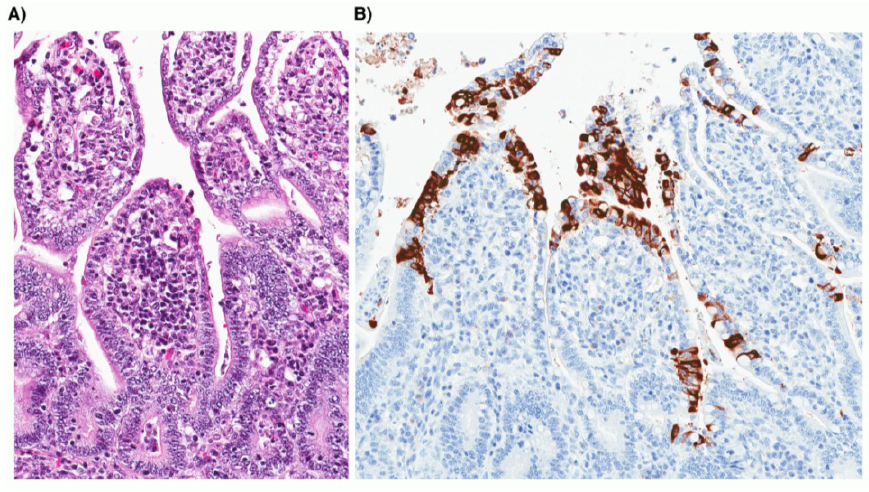
Figure 4. Photomicrographs of small intestine taken from a two-week-old puppy with typical lesions of CCoV infection. ( A ) Severe atrophy of intestinal villi with attenuated low cuboidal to squamous enterocytes (hematoxylin and eosin stain; 20× original magnification). ( B ) Coronavirus antigen is present within the cytoplasm of infected villous enterocytes (immunohistochemistry; 20× original